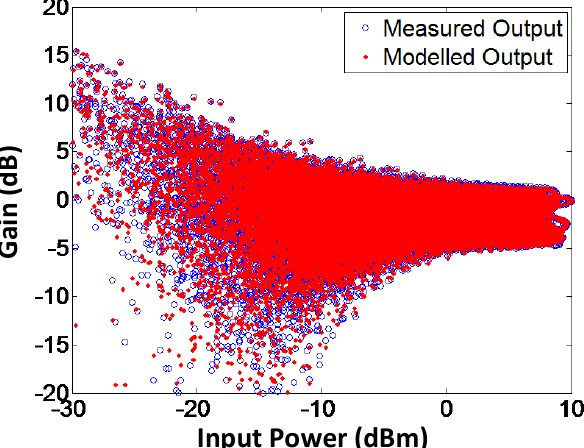
Figure 11. AM-AM characteristics of modeled and measured output signals for the analog combining architecture. Similar to when digital combining is used, the proposed method works effectively for modeling the gain response of the transmitter using analog combining.